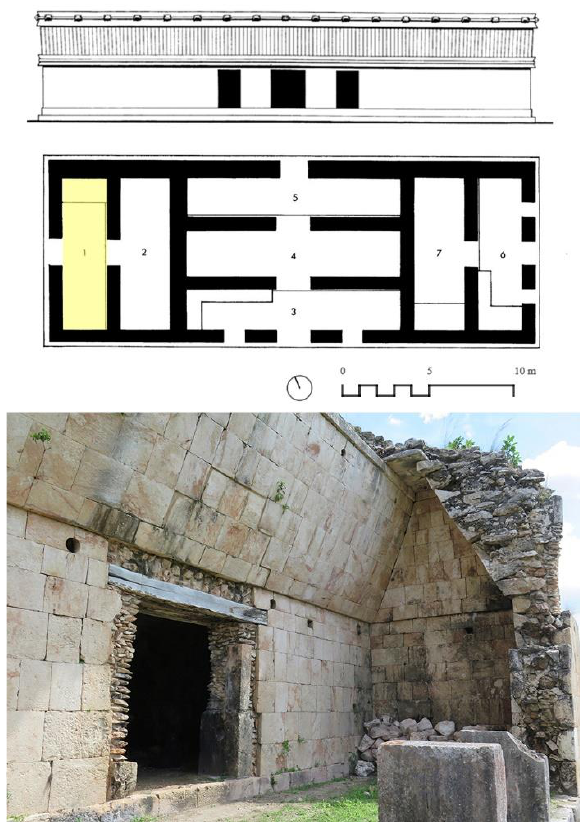
Figure 7. Plan and south elevation of the House of the Turtles by G. Andrews (1993) and north-west view of room 1.